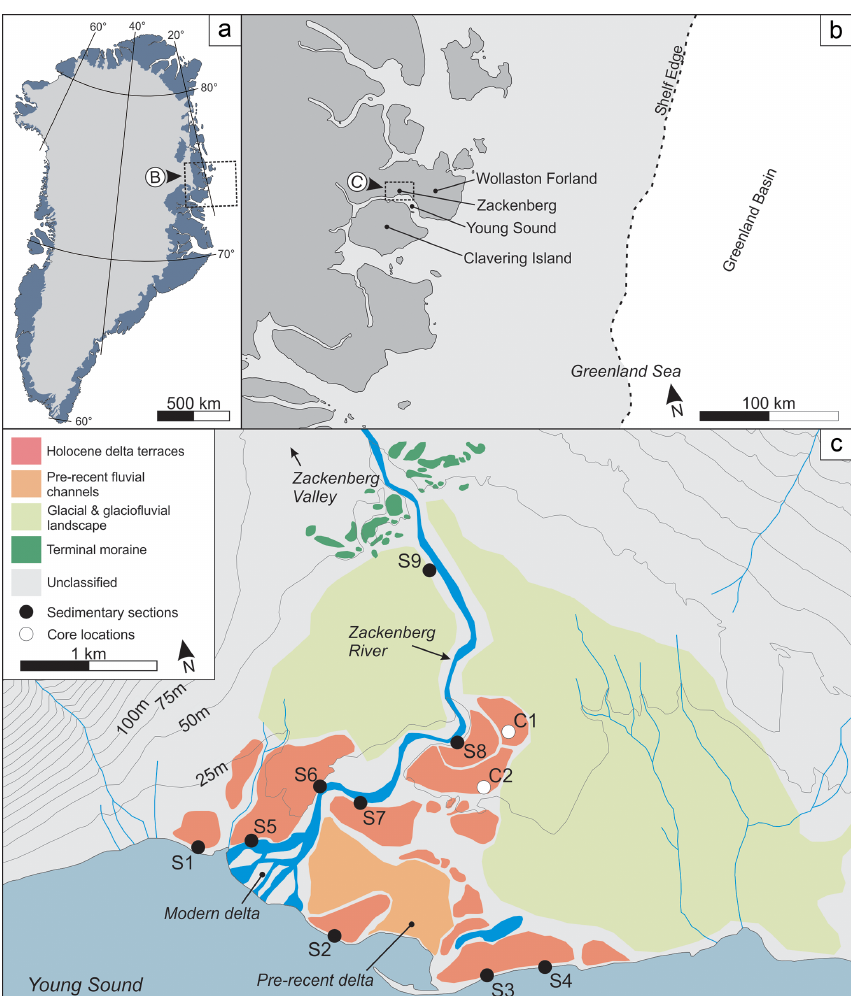
Figure 1. (a) Location of the study region in northeast Greenland. (b) Regional map of central northeast Greenland showing the location of the study area and key locations mentioned in the text. (c) Details of the study area in the Zackenberg lowlands. The glacial and glaciofluvial landscape formed during the late Weichselian, whereas the delta terraces are of late Weichselian to Holocene age. The location of sections (S1–S9) are denoted by black dots. Sediment core locations (C1 and C2) are denoted by white